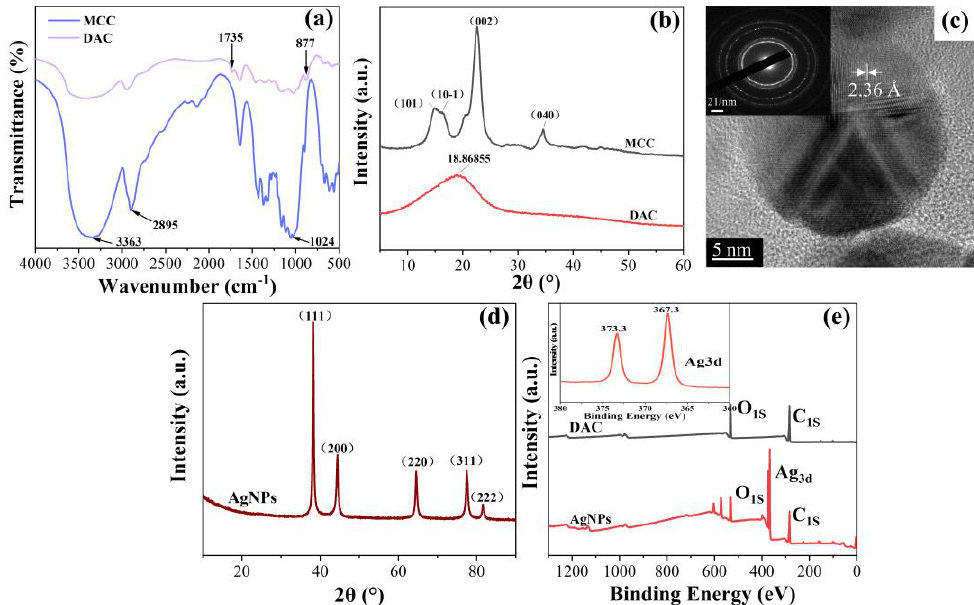
Figure 5. FT-IR spectra ( a ) and XRD spectra ( b ) of MCC and DAC, ( c ) in high resolution, ( c , inset) selected area electron diffraction of AgNPs, ( d ) XRD spectra of AgNPs, ( e ) XPS spectra of DAC and